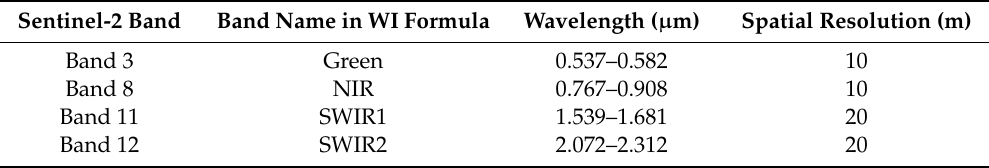
Table 1. The Sentinel-2 Level-1C bands used in this